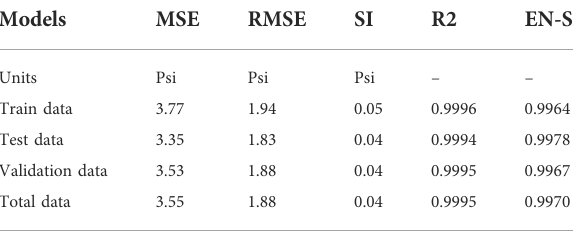
TABLE 2 Prediction of PP based on GS-GMDH model for train (70% of total data), test (15% of total data), validation (15% of total data)